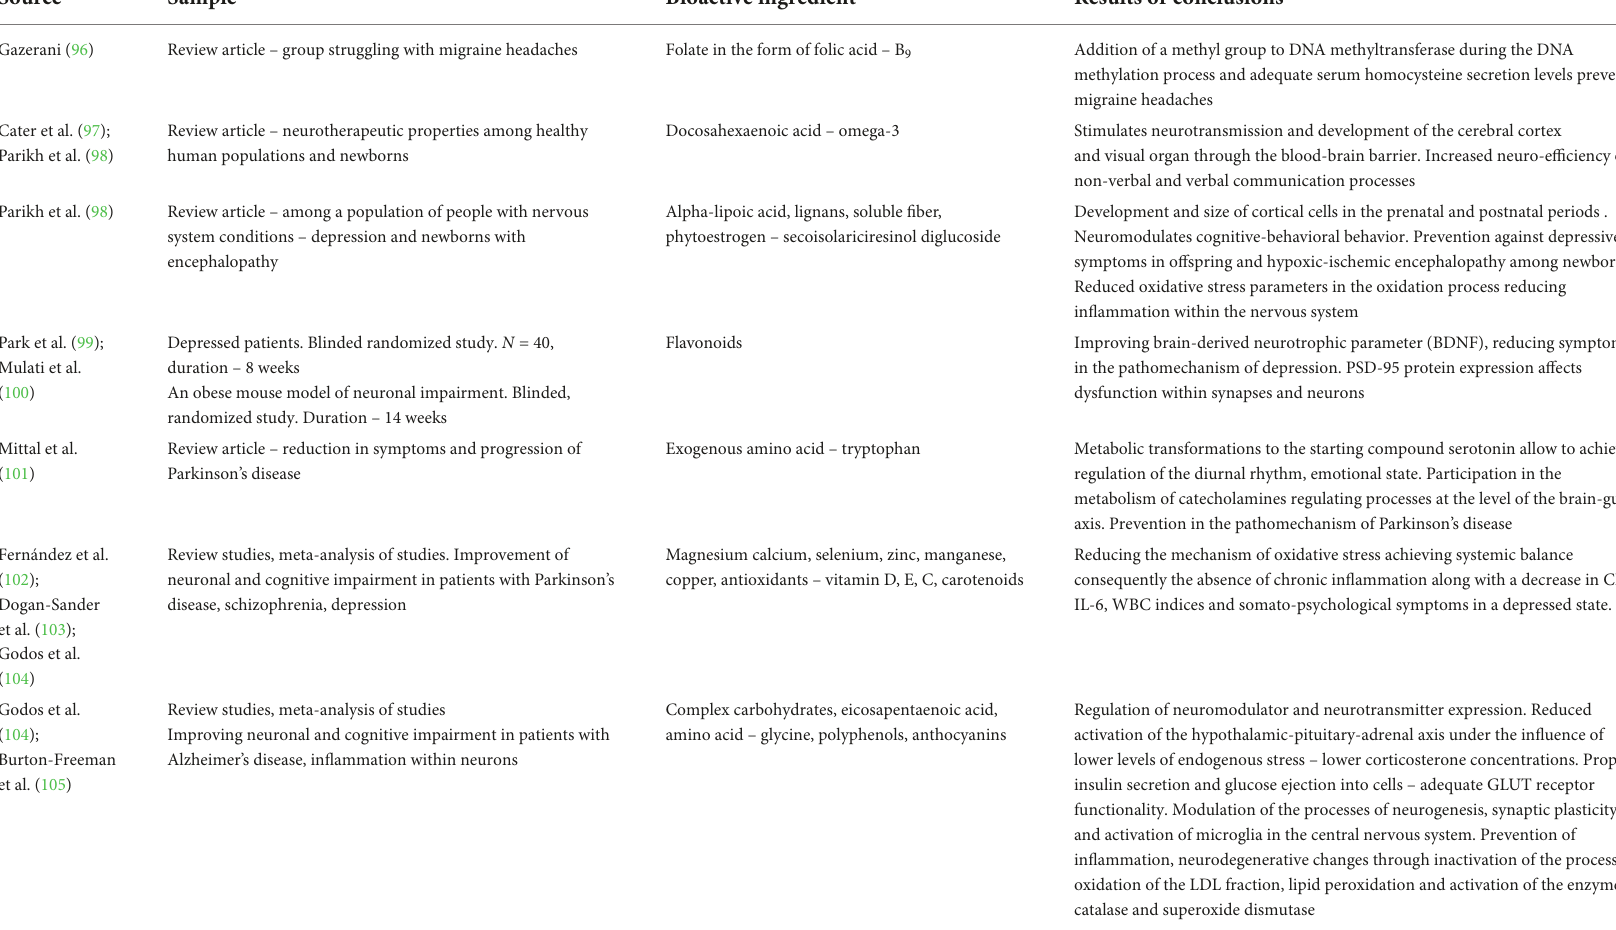
TABLE 1 Review of selected studies on the psychoprotective effect of